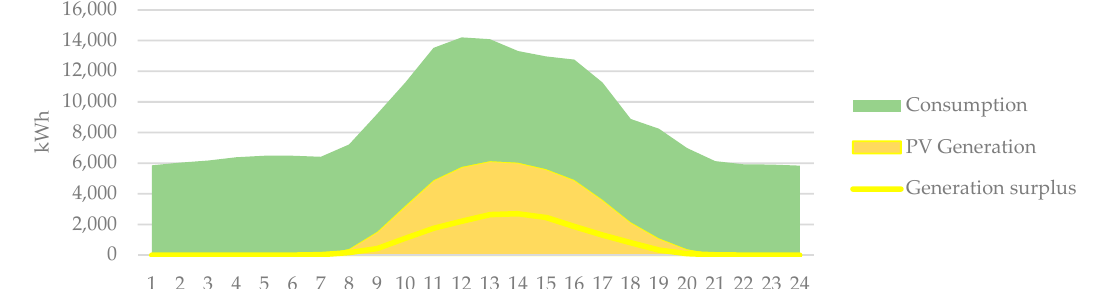
Figure 10. Sum of hourly photovoltaic generation, electricity consumption and surplus renewable generation from the 4 public buildings in Alf â ndega da F é during the 6-month trial period. Source: Authors’ own